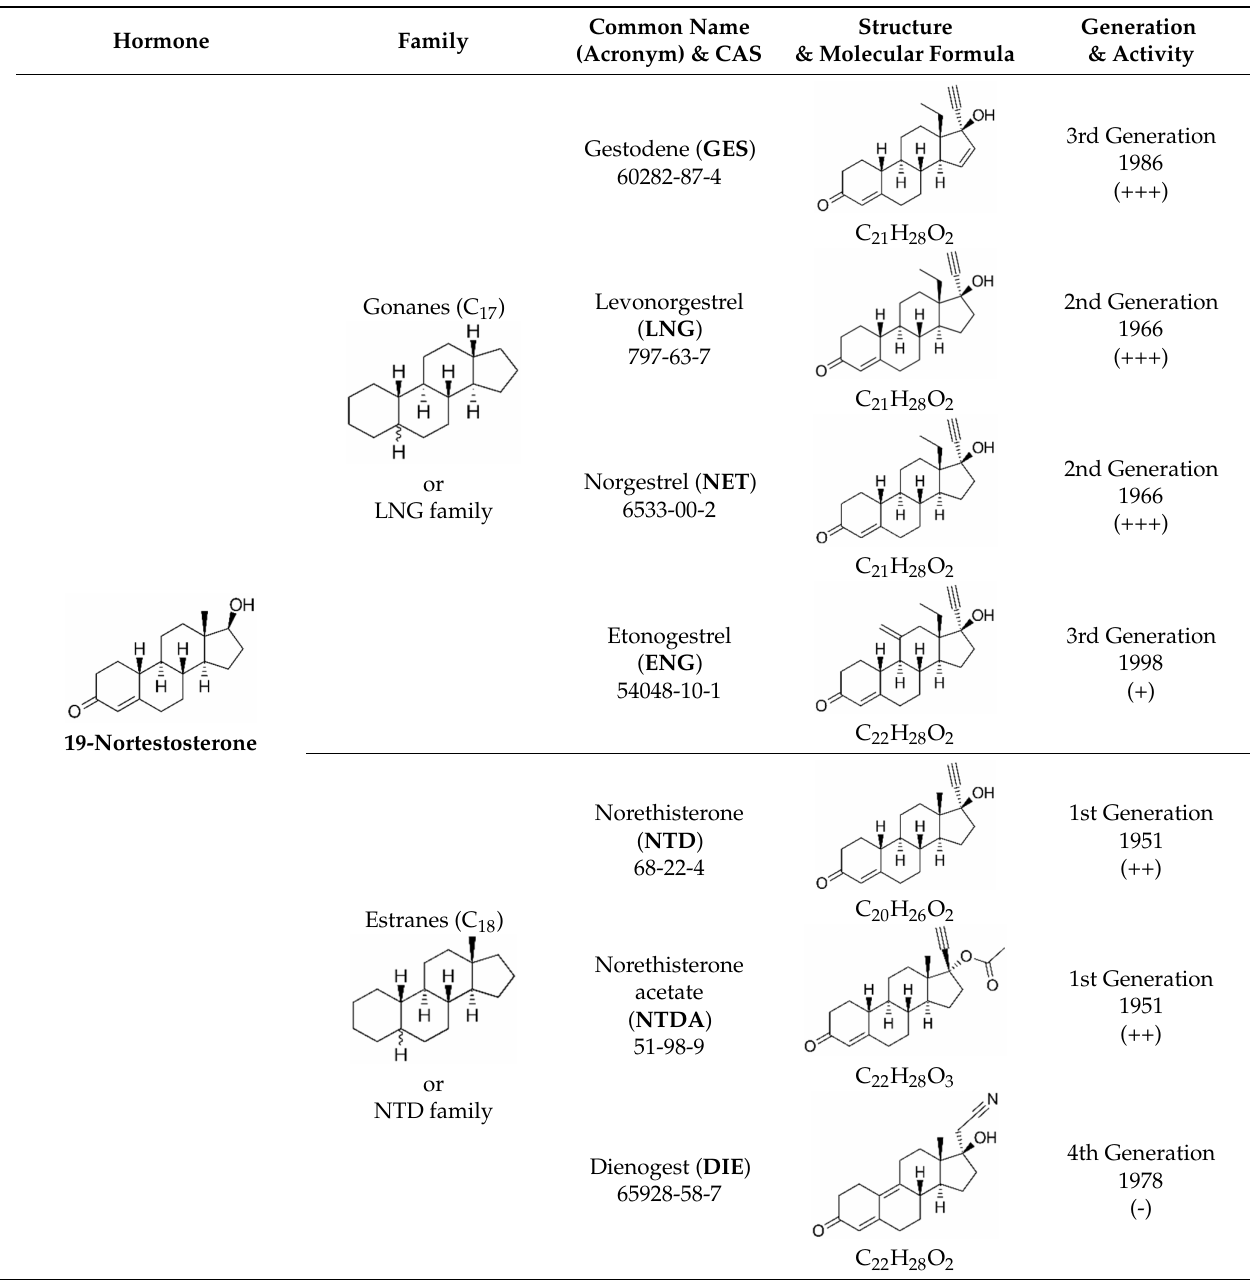
Table 1. Pharmacological groups of the selected progestins referred to in this article considering their structural derivation, generation, and androgenic effects in humans: (+++) highly androgenic; (++) medium androgenic; (+) low androgenic; (-) no androgenic